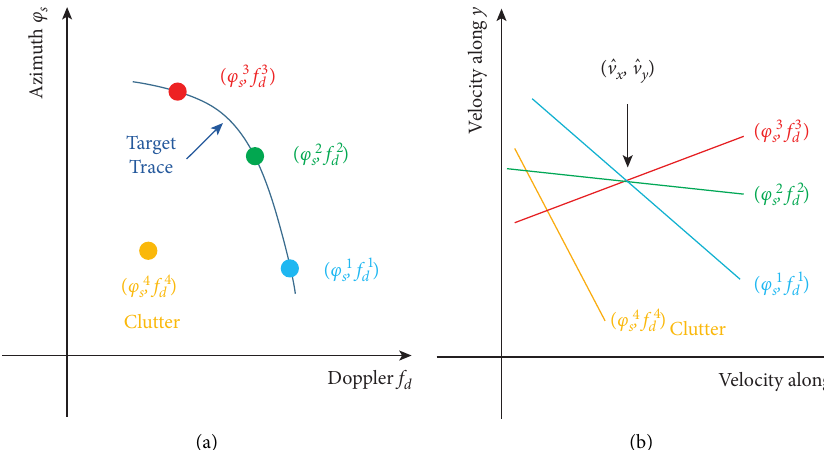
Figure 7: Measurement space and parameter space of constant velocity equation. (a) Measurement data space. (b) Velocity parameter